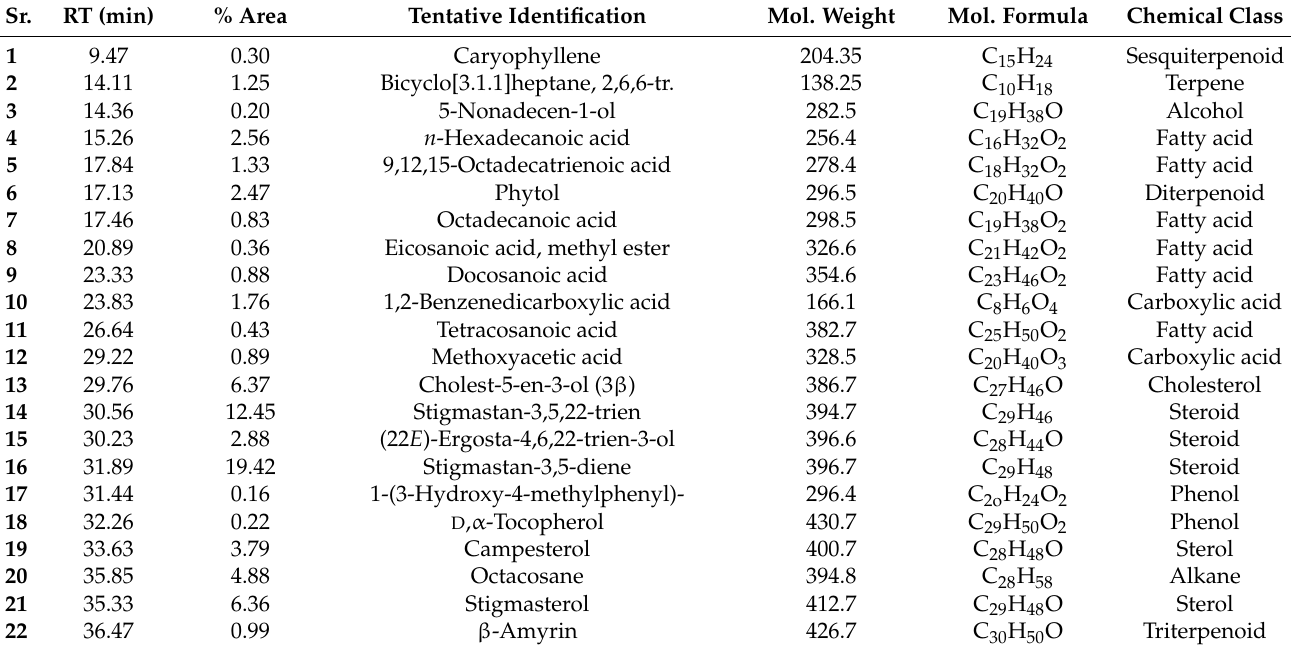
Table 3. GC-MS analysis of Neurada procumbens n -hexane fraction.